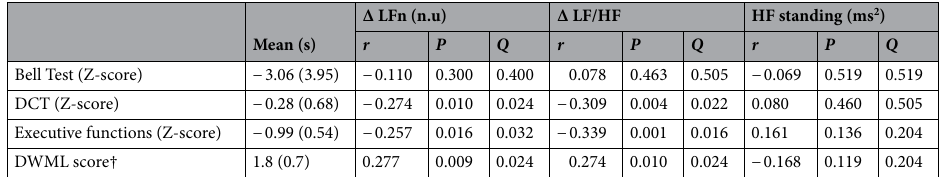
Table 6. Correlations of HRV indices with attention and executive tests and cerebrovascular burden in the naMCI group. Spearman’s correlation analysis adjusted for hypertension, physical activity and trait anxiety. Correlations with DCT and executive scores also demographically-adjusted. Cognitive Z-scores and visual rating scale scores expressed as mean (standard deviation). naMCI, non-amnestic mild cognitive impairment; LFn, low frequency power (normalised); n.u, normalised units; LF/HF, ratio of low frequency power (LF) to high frequency power (HF); Δ HRV index, standing HRV index—baseline HRV index; DCT, digit cancellation test; DWML, deep white matter lesions. s , standard deviation; r , Spearman’s correlation coefficient; P , adjusted P -value; Q, adjusted P -value corrected for multiple testing with the Benjamini–Hochberg procedure with a 5% False Discovery Rate (FDR). † On